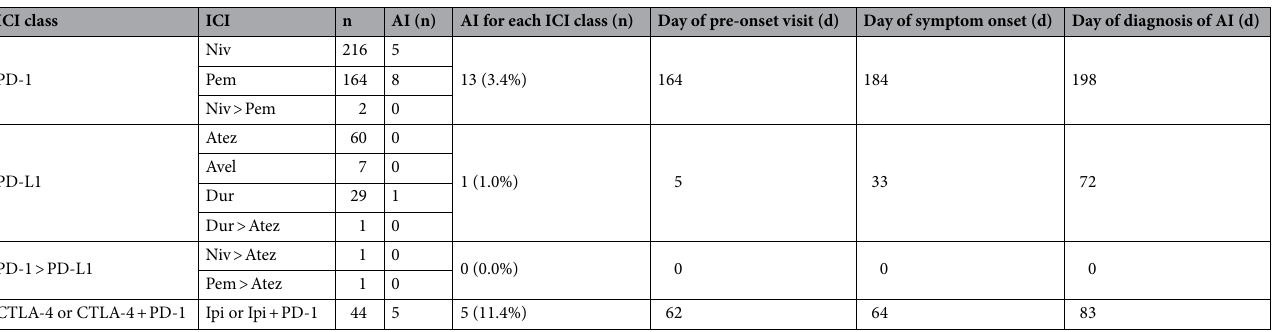
Table 2. Clinical course of patients with pituitary AI. A > B indicates change of ICI from A to B. ‘Day’ is the median number of days from the first administration of ICI. Abbreviation: AI adrenal insufficiency, Atez atezolizumab, Avel avelumab, CTLA-4 cytotoxic T-lymphocyte-associated protein 4, Dur durvalumab, ICI immune checkpoint inhibitor, Ipi ipilimumab, Niv nivolumab, PD-1 programmed cell death-1, PD-L1 programmed death-ligand 1, Pem pembrolizumab.